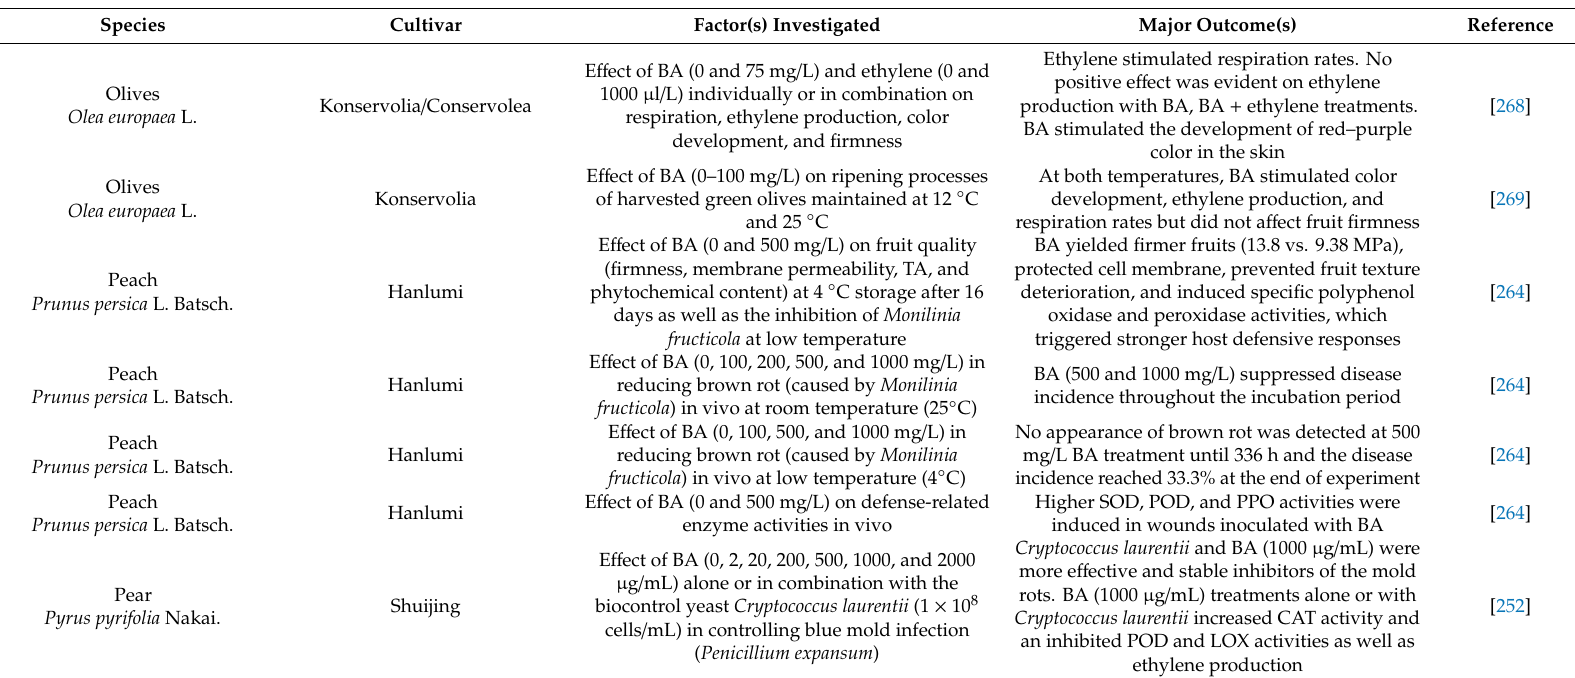
Table 10. E ff ects of postharvest application of cytokinins on postharvest quality of horticultural